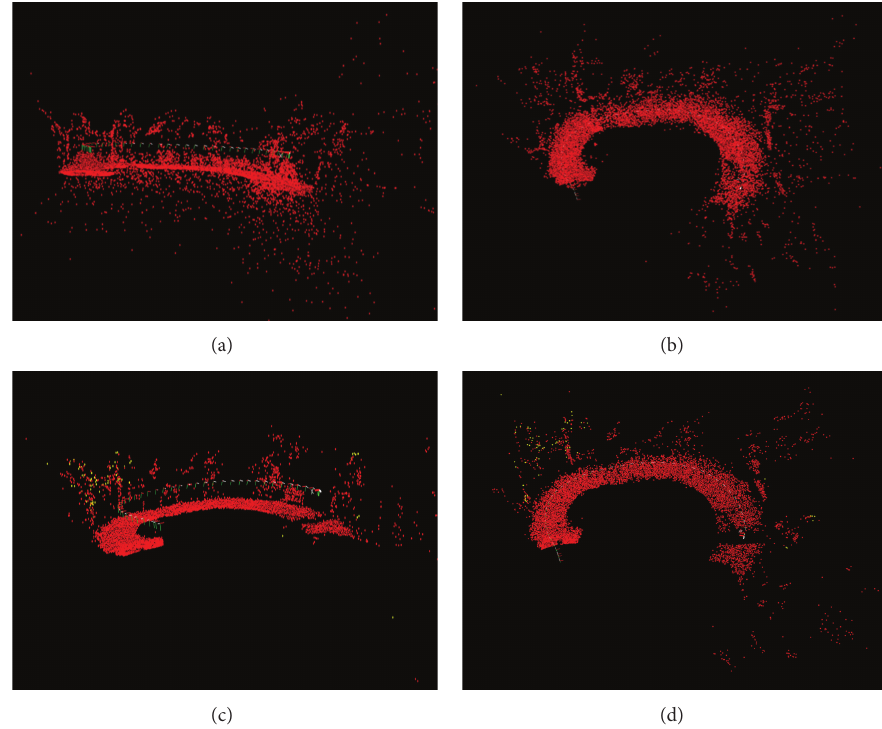
Figure 7: Themapping result: (a)and (c) are generated by original PTAM algorithm and proposed algorithm; (b) and (d) arethe downlooking of (a) and